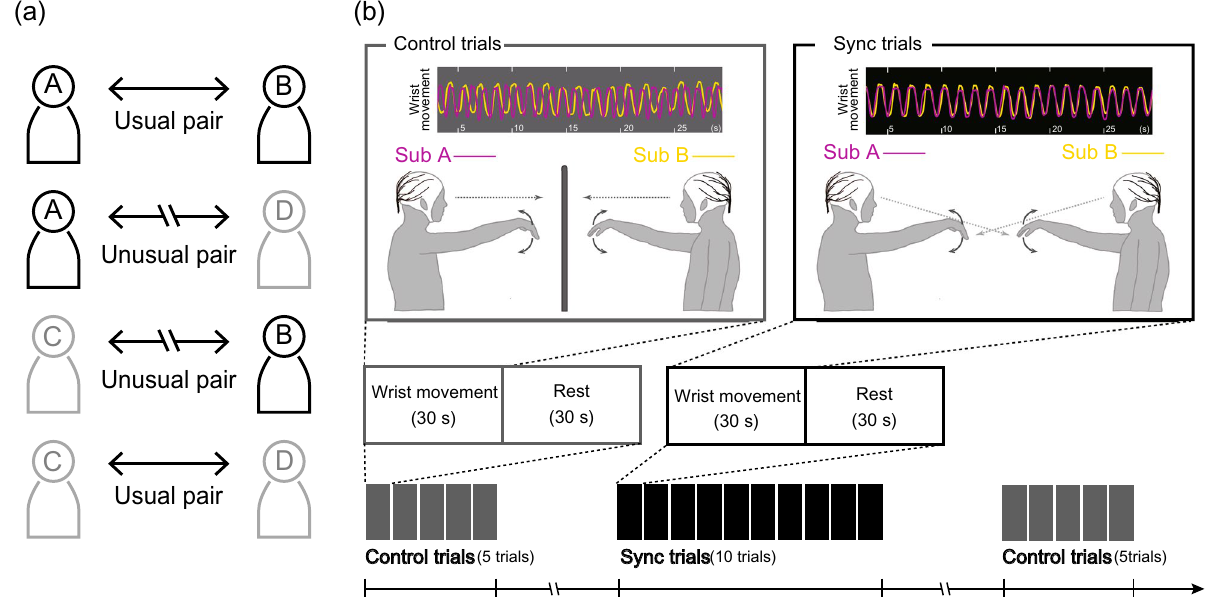
Figure 5. ( a ) Schematic illustration of the pairing. ( b ) Schematic illustration of the wrist movement task. Typical examples of wrist movements in the control and sync